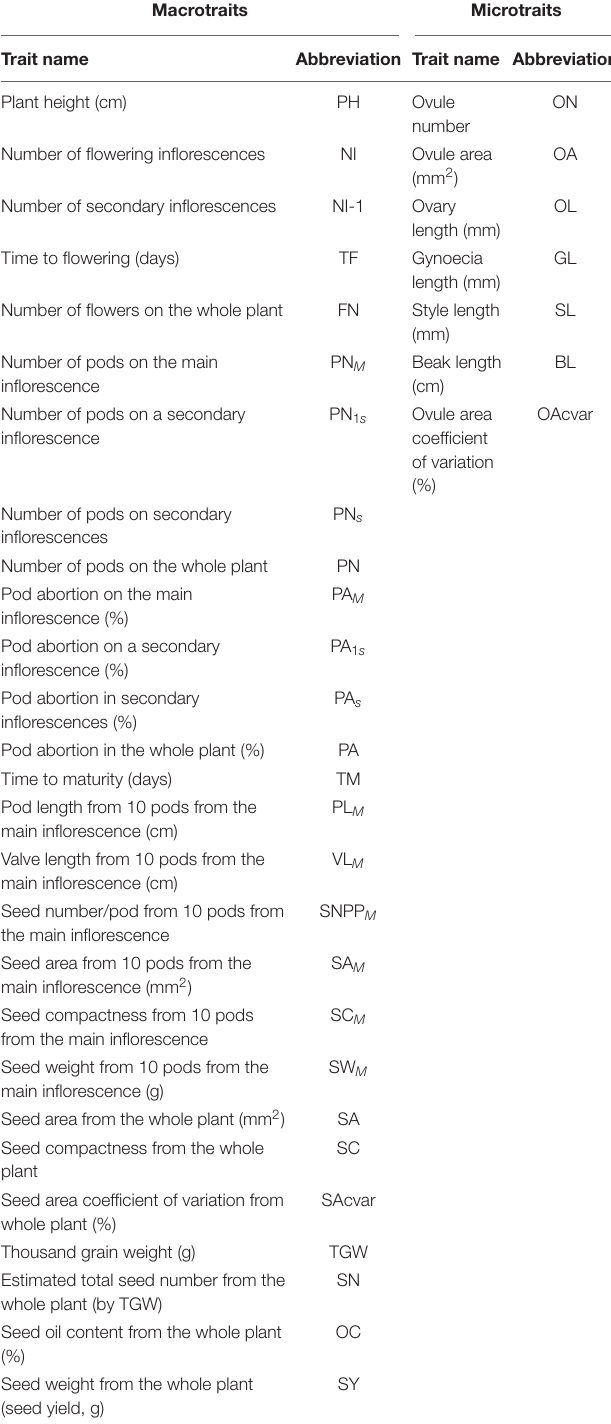
TABLE 1 | List of macrotrait ( n = 5) and microtrait ( n = 3) names and abbreviations measured in the diversity set